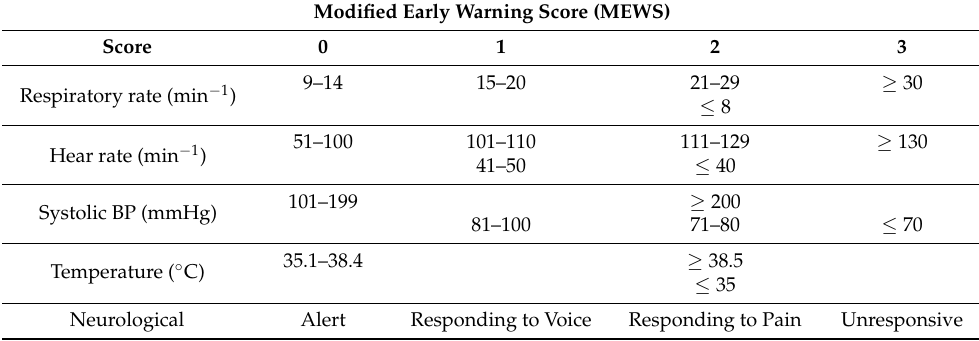
Table 2. Modified Early Warning